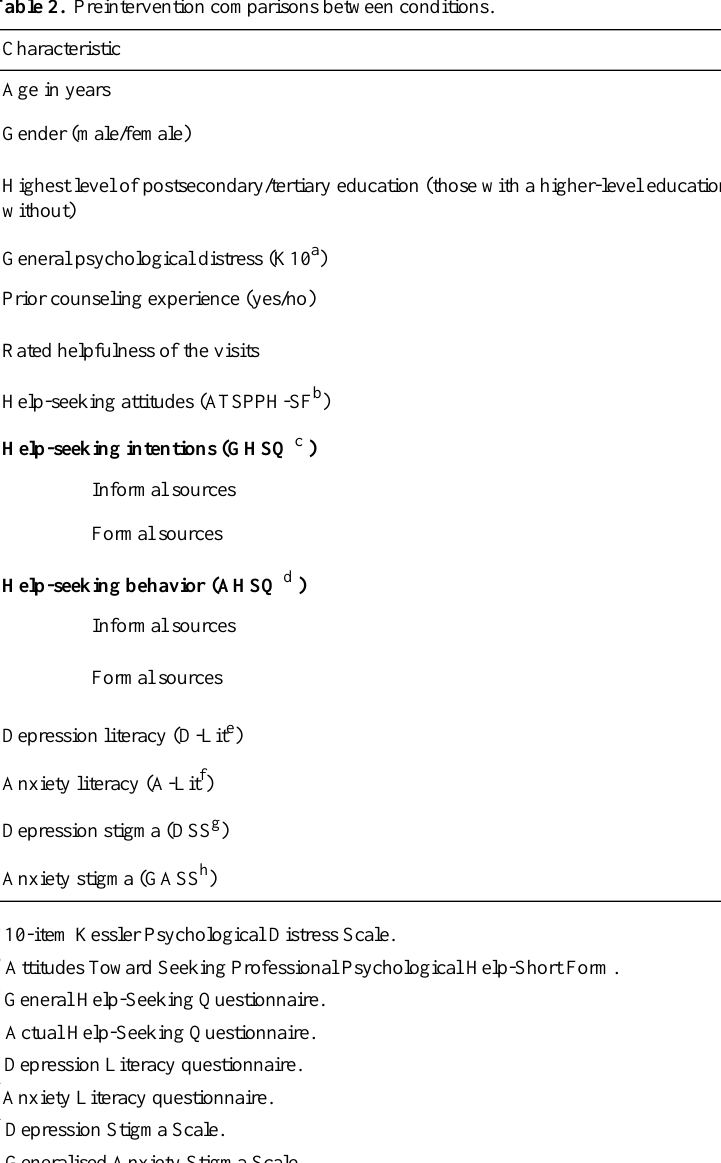
Table 2. Preintervention comparisons between conditions.